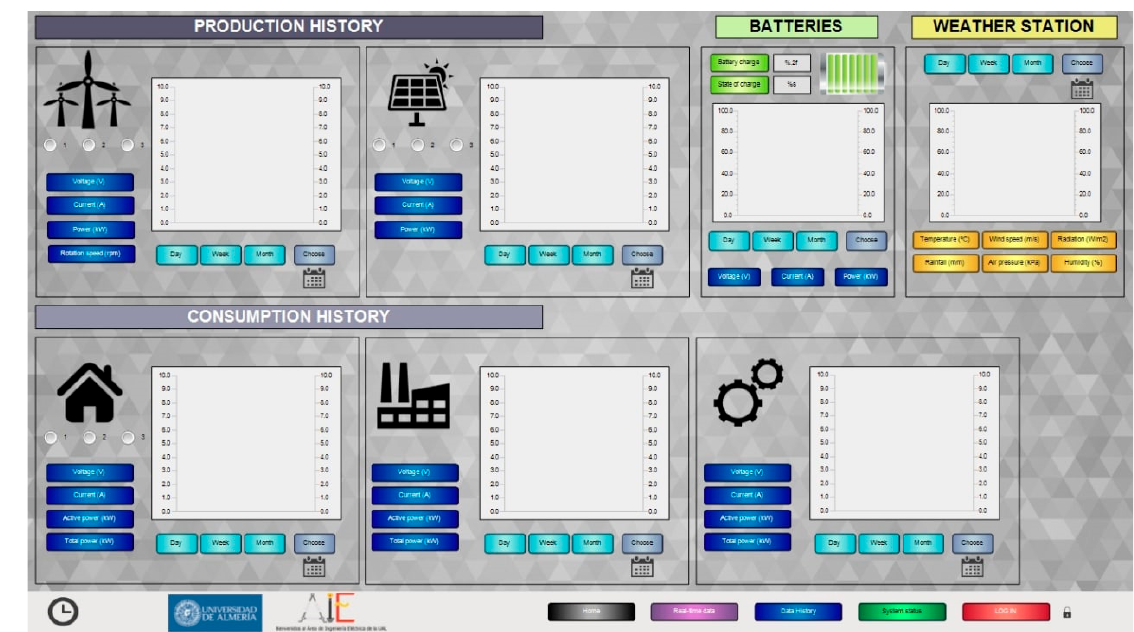
Figure 9. Data history for energy production and demand.